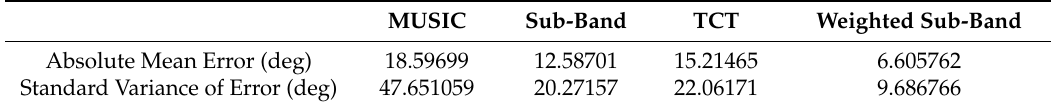
Table 1. DOA Error Statistics for Various